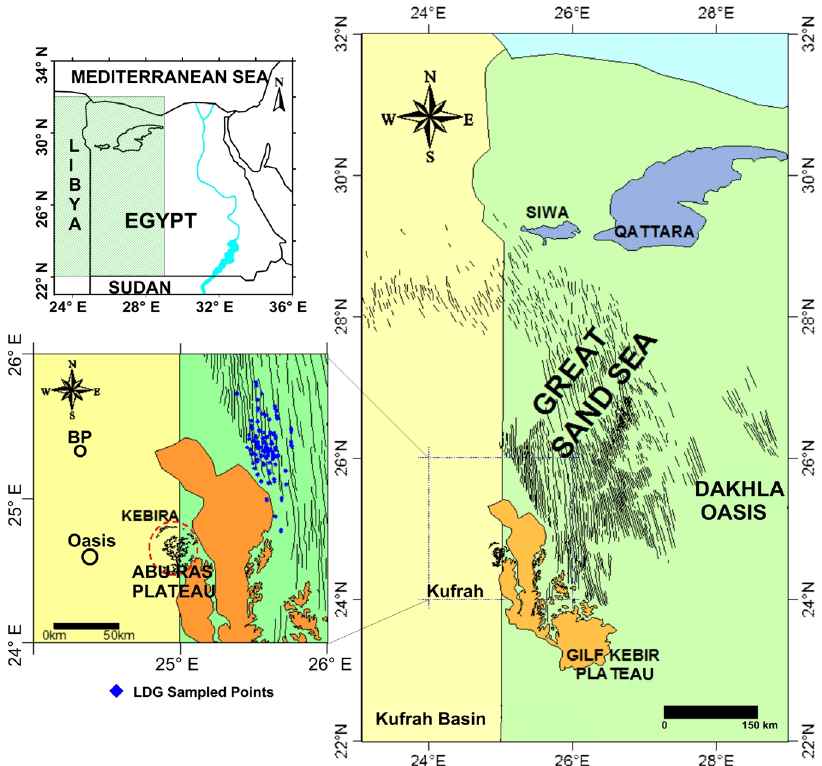
Figure 2. Principal geomorphological features in the Western Desert,